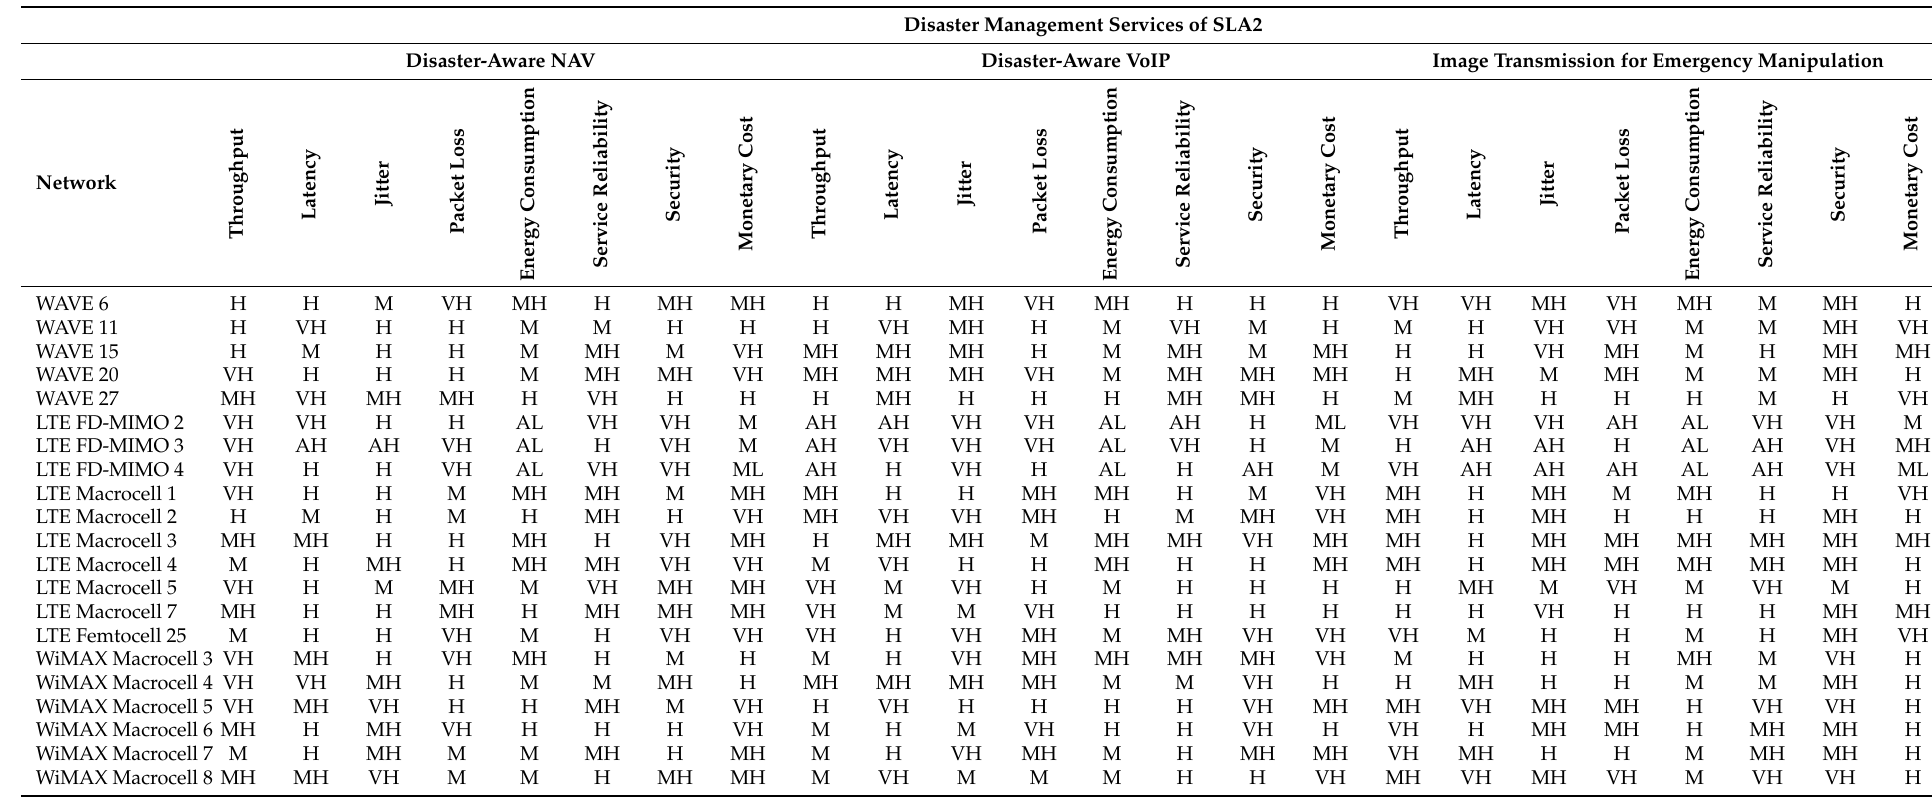
Disaster Management Services of SLA2